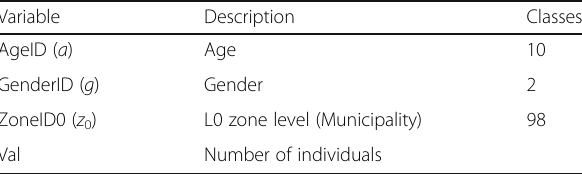
Table 4 Target T ga ( z 0, g , a ) for age, gender and municipality level